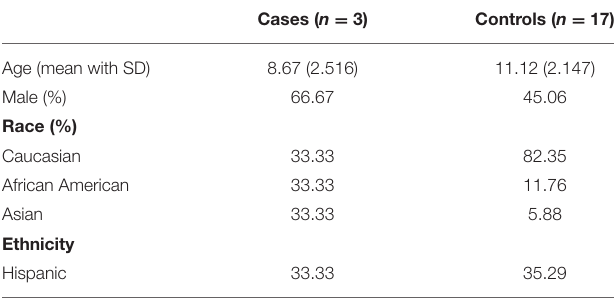
TABLE 2 | Study population